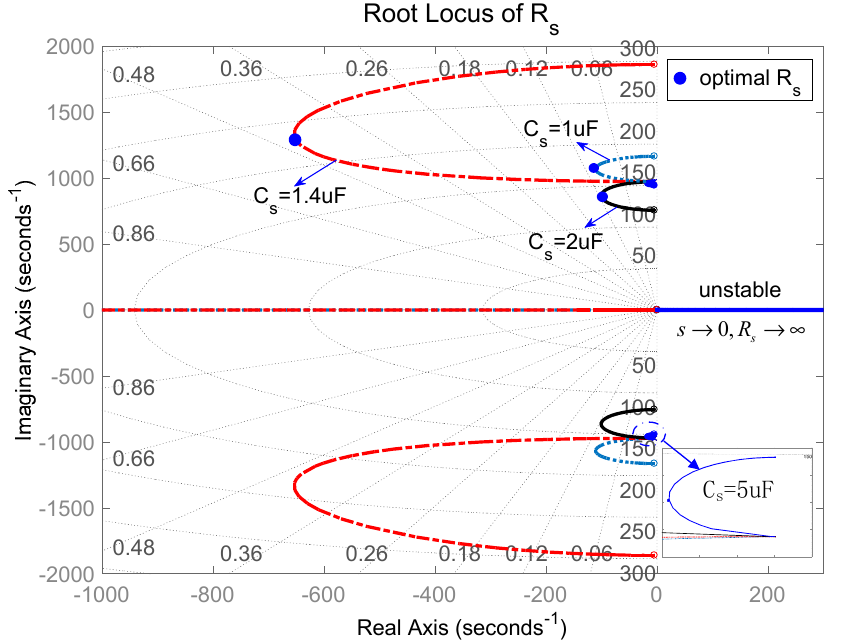
Figure 13. Root locus of the piezoelectric stack transducer with respect to R s for the negative capacitance in parallel with R s .